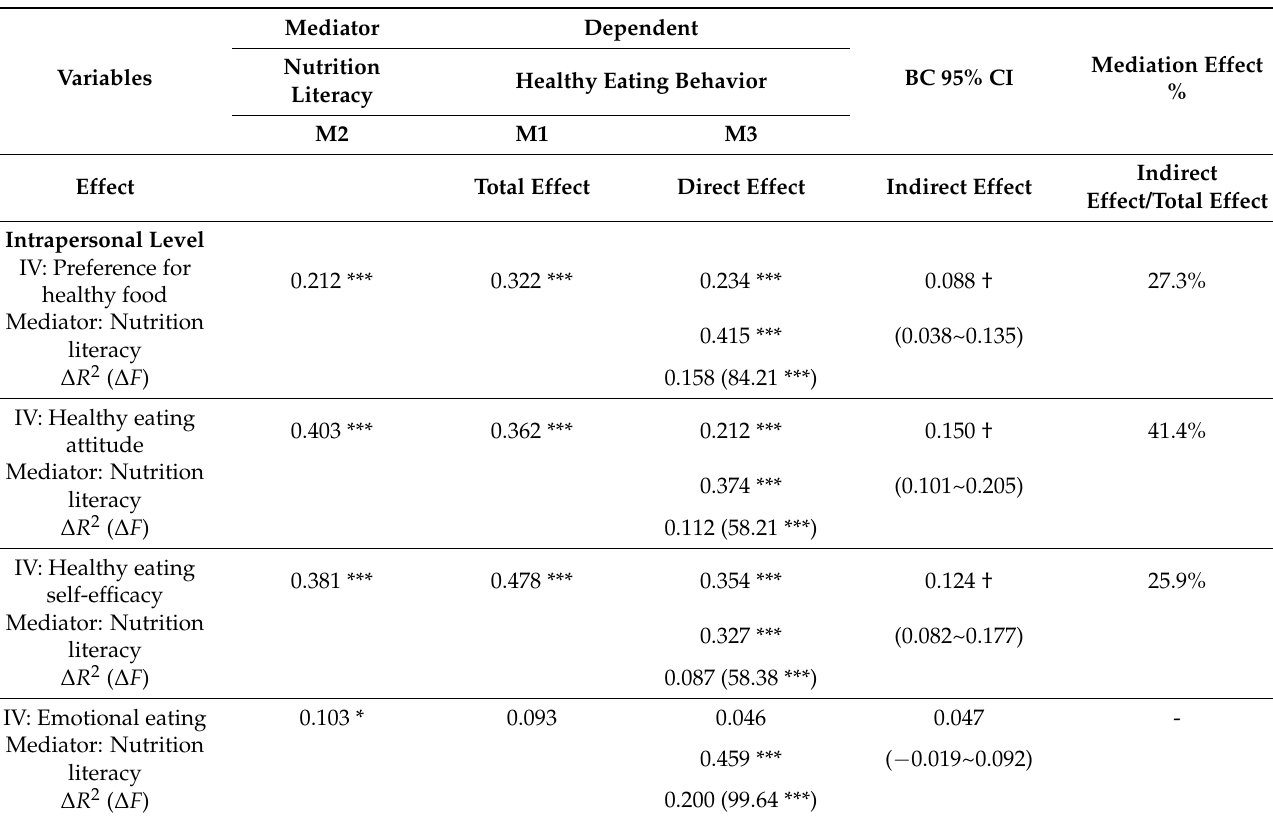
Table 4. Summary of the Mediating Effects of Nutrition